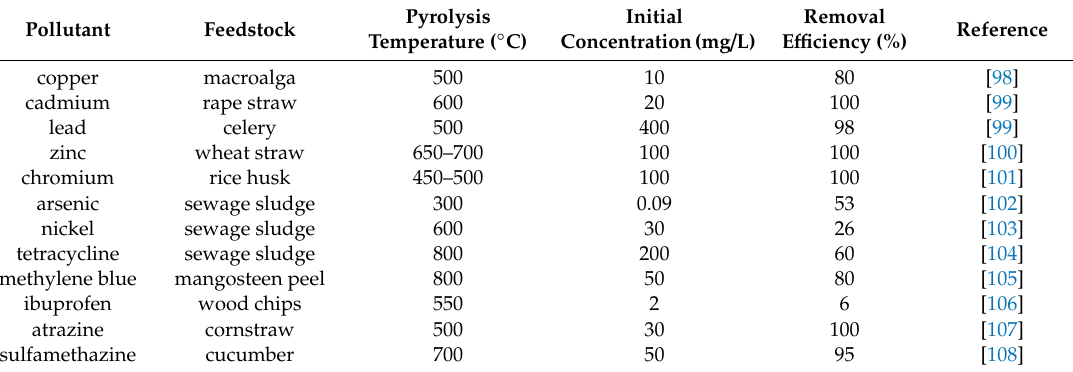
Table 1. Removal of inorganic and organic pollutants from aqueous solutions by